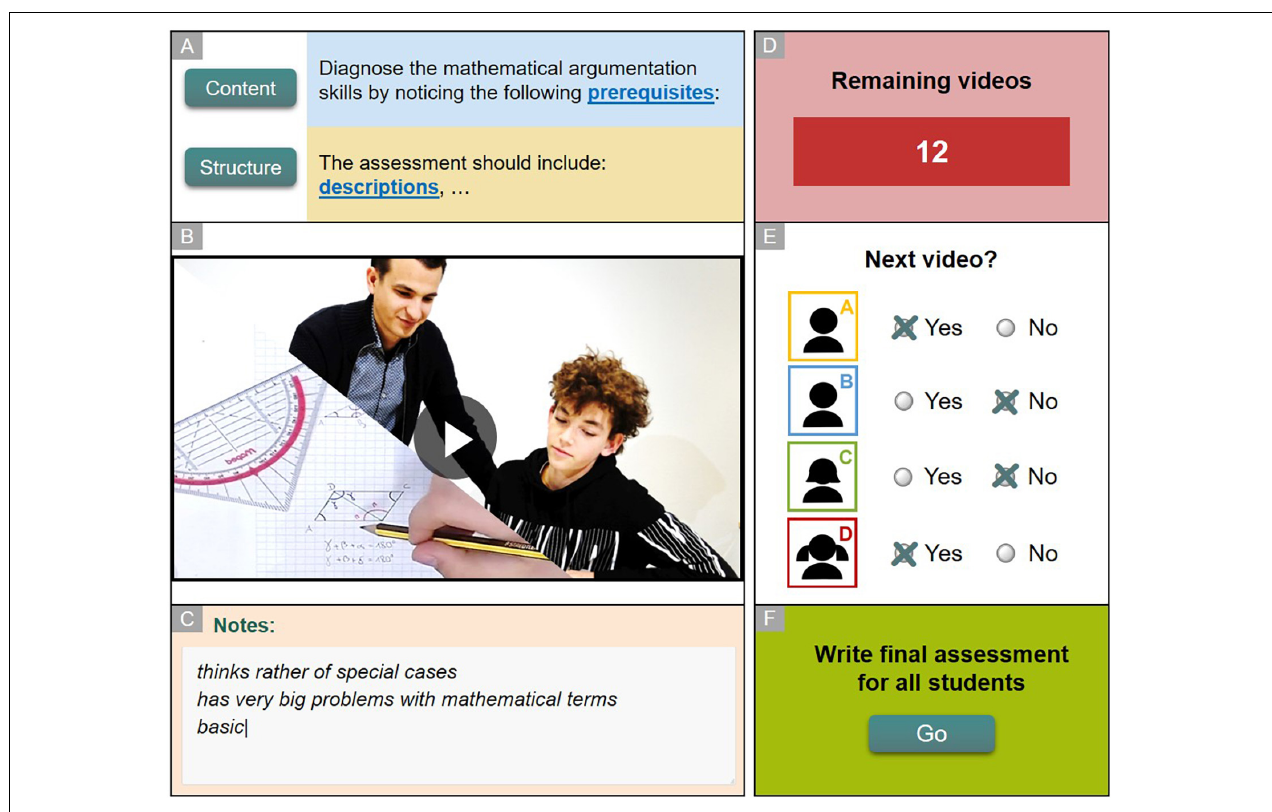
FIGURE 3 | Outline of the assessment process in the video-based simulation with the areas (A) Introduction to assessment task. (B) Video clips showing the teacher-student interactions. (C) Participants’ notes. (D) Number of remaining video clips. (E) Participants’ influence on the course of actions in the simulation. (F) Final